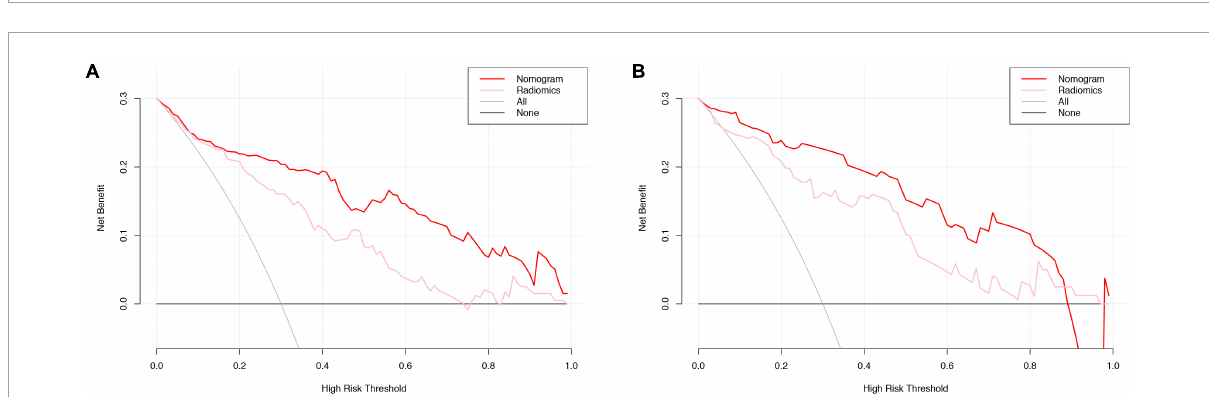
FIGURE7 DCA curve evaluation of the clinical utility of the radiomic signature and the radiomic nomogram. Training cohort evaluation (A) and validation cohort evaluation (B) . The net benefit is shown on the y-axis. The threshold probability is shown on the x-axis. The maximum net benefit was obtained employing the radiomic nomogram (red line) in comparison with and the treat-none strategy (horizontal black line), the treat-all strategy (gray line), and the radiomic signature (pink line). DCA, decision curve